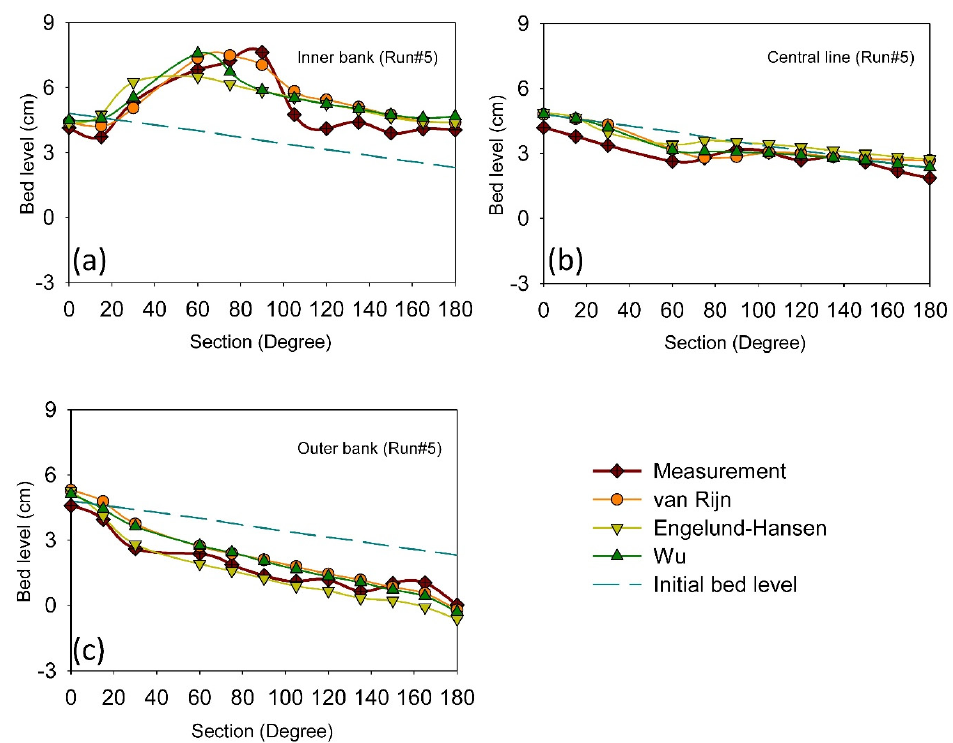
Figure 3. Initial and final bed levels of Run#5 along three longitudinal sections, ( a ) 10 cm from the inner bank, ( b ) the central line, and ( c ) 10 cm from the outer bank.